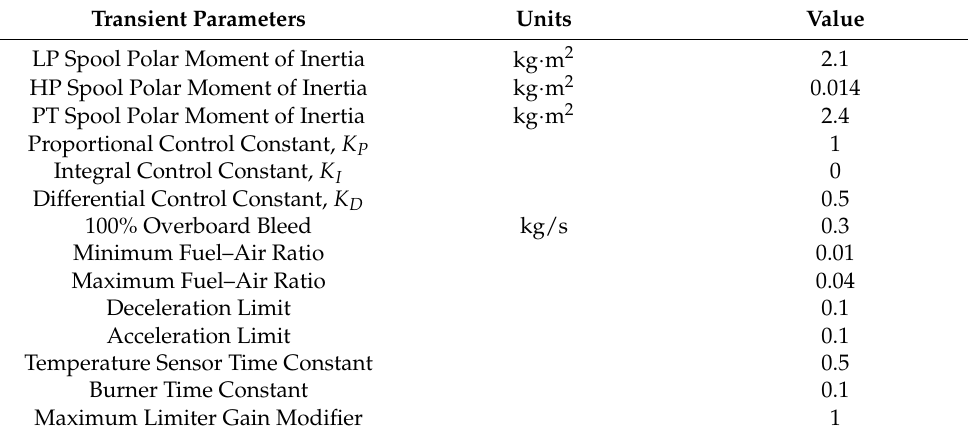
Table 9. Transient input